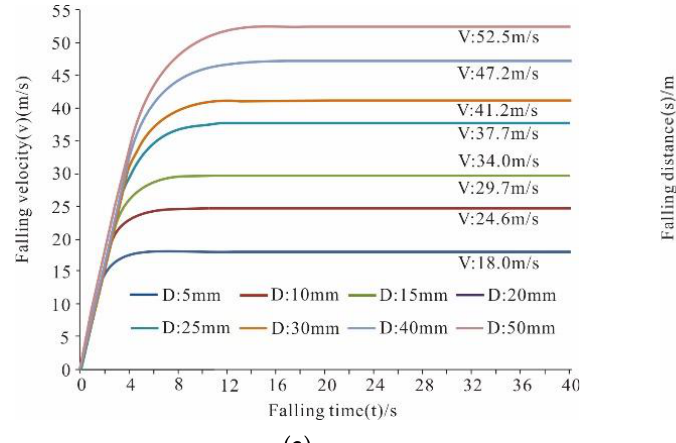
Figure 26. Vertical and horizontal transport systems for gangue filling materials: ( a ) vertical dump- ing system of gangue; ( b ) gangue conveyer.